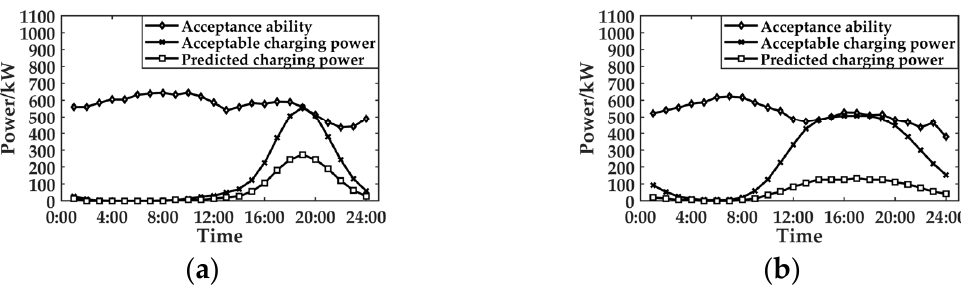
( b ) Figure 11. The maximum charging load that can be connected to each partition of the distribution network. ( a ) Weekdays, ( b ) Weekends. ( a ) ( b ) Figure 12. Node voltage at the maximum output power of node 1 of the distribution network. ( a ) Weekdays, ( b ) Weekends. Nodes 5, 13, 20, and 35 are located in the power supply area’s first-level charging